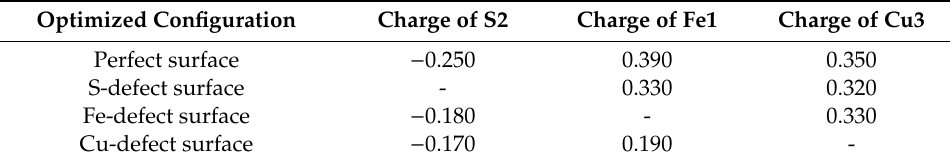
Table 3. Surface charge comparison.